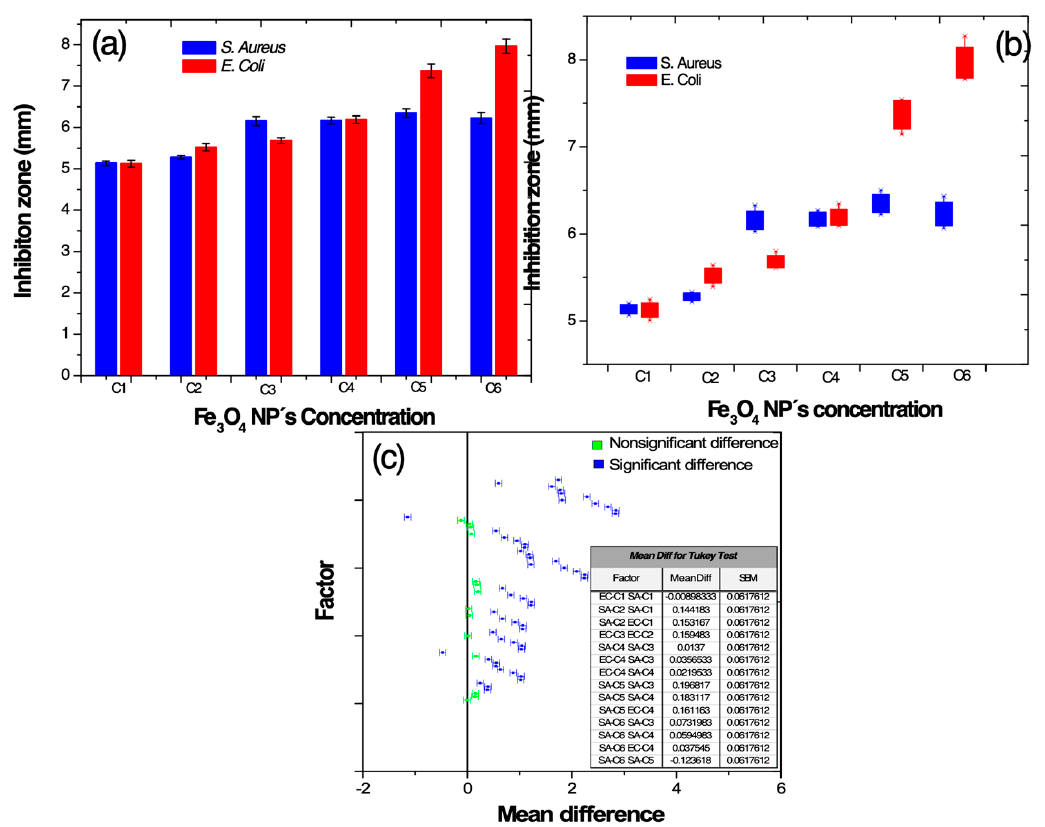
Figure 10. ( a ) Bar graphs of the diameter of the inhibition zone measured from the bacterial susceptibility, ( b ) box-plot of antibacterial activity of Fe 3 O 4 against S. aureus and E. coli bacteria. ( c ) Scatter plot of Tukey comparison by pairs.